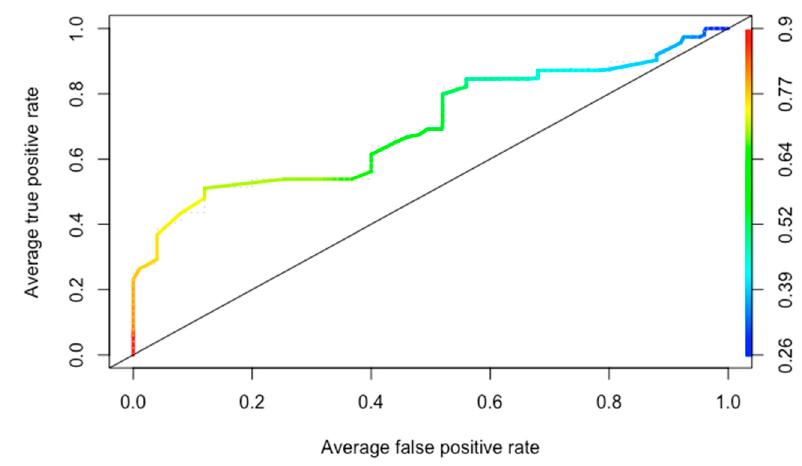
Figure 2. Receiver operating characteristic curve.